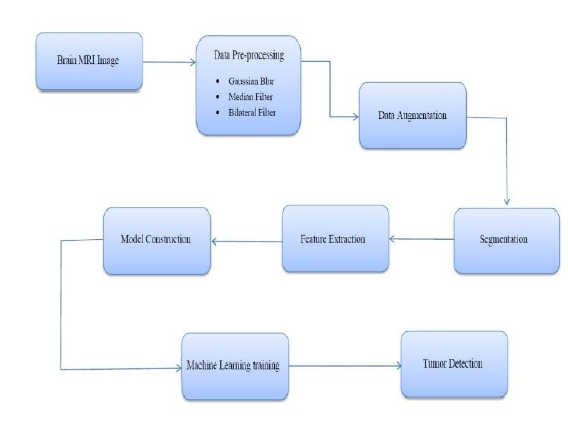
Figure 1. Proposed